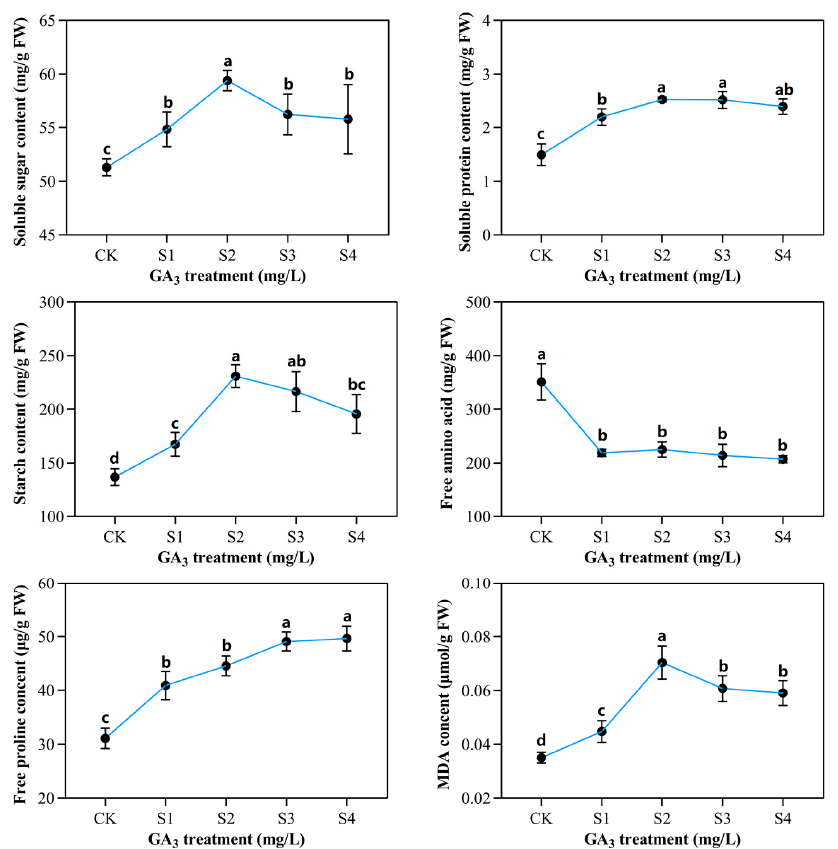
Figure 4. The outcome of varying exogenous GA 3 concentrations on organic sorghum seedlings content developed under 150 mM NaCl conditions. CK—0 mg/L GA 3 ; S1—25 mg/L GA 3 ; S2—50 mg/L GA 3 ; S3—75 mg/L GA 3 ; S4—100 mg/L GA 3 . Six sorghum plants from GA 3 treatment (n = 3) and control group (n = 3) were used for the determination of organic content, including soluble sugar, soluble protein, starch content, free proline, MDA levels, and free amino acid. All data are presented as the mean ± SD, Superscript different lowercase letters means significant difference ( p < 0.05), Superscript same lowercase letters means significant difference showed no significant difference ( p > 0.05).